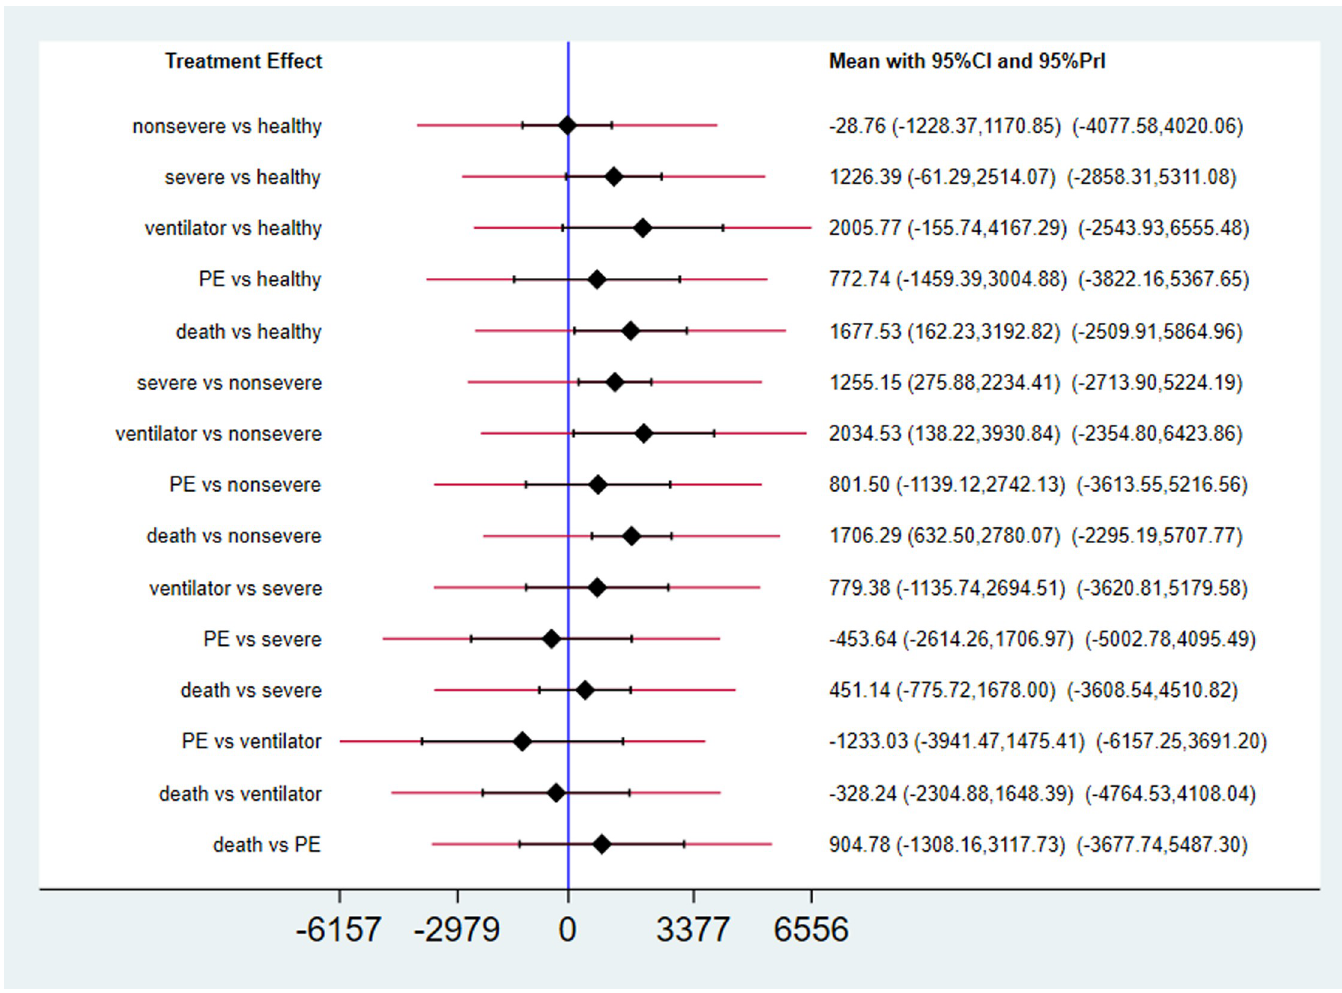
Fig 6. Forest plot of network meta-analysis of SMD of d-dimer levels of patients with different outcomes. The red lines show prediction interval of future research. PrI = prediction interval. SMD = standardized mean difference.